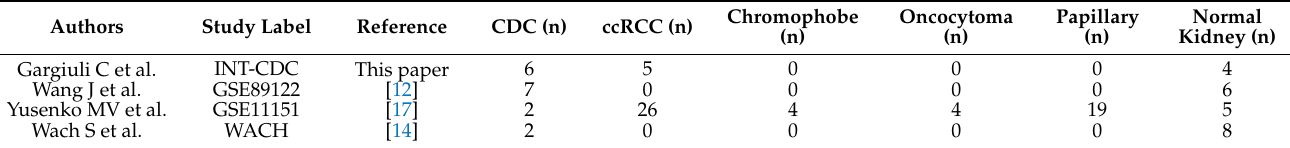
Figure 1. Differential gene expression between CDC and normal kidney. ( A ) Volcano plot showing differentially expressed genes between CDC and normal samples in INT dataset. The x -axis shows the log2 fold change. The y -axis shows the − log10 of the false discovery rate. An absolute log2 fold-change ≥ 1 and an FDR < 0.25, represented by the vertical and horizontal dashed lines, respectively, were used to select differentially expressed genes. Up- and downregulated genes in CDC are highlighted in red and blue, respectively. The top-10 up- and downregulated genes are reported. ( B ) Enrichment plots from GSEA conducted with the INT signature of up- and downregulated genes in CDC in three independent datasets of CDC and normal kidney samples. The red-to-blue color bar shows the ranking of the genes of each dataset from up- to downregulated in CDC. The vertical black bars indicate the position of the genes in the INT signatures along the ranked gene list. The green line shows the running enrichment score (ES) along the ranked gene list. NES: normalized enrichment score. Table 2. List of CDC gene expression datasets analyzed in the